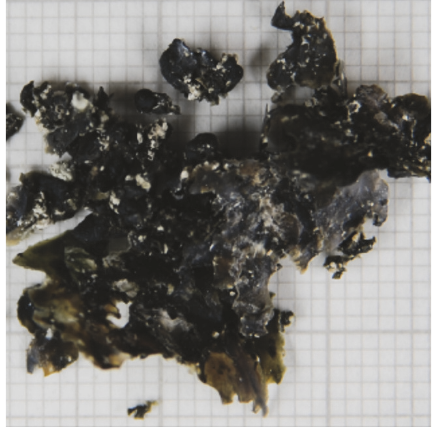
Figure 3: Macroscopic appearance of stone following PCNL. One small square equals 1mm ×